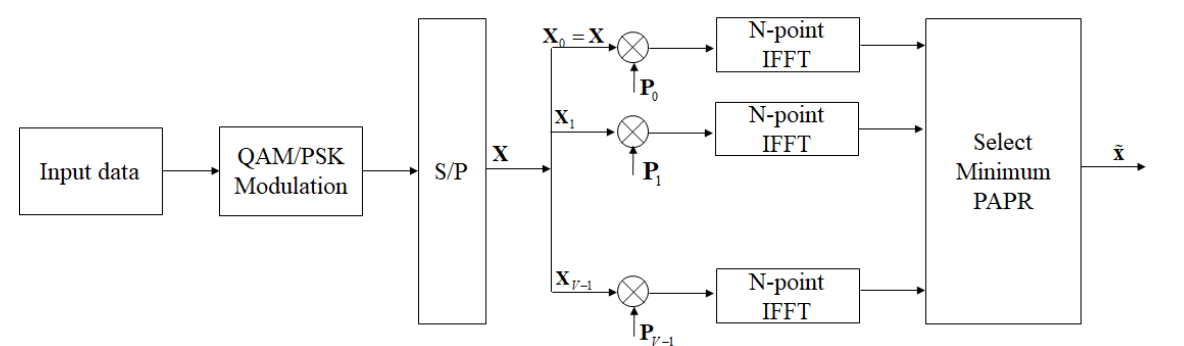
Figure 2. The block diagram of the SLM scheme in OFDM